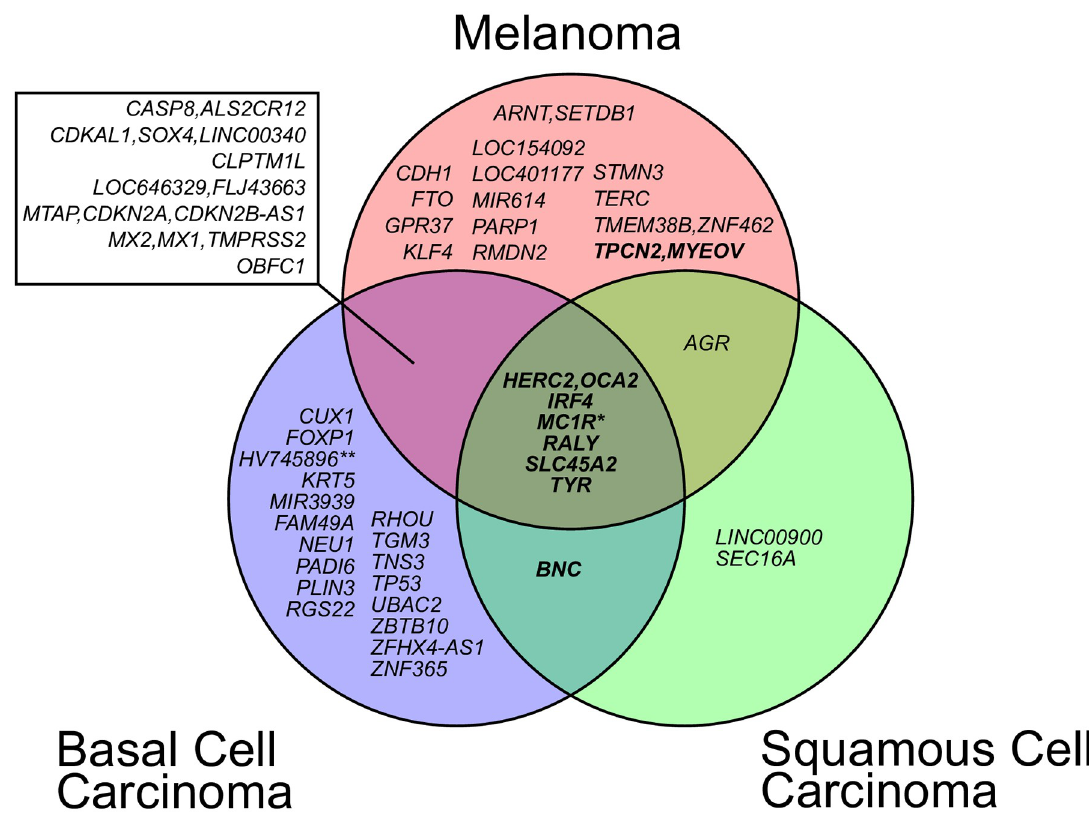
Fig 2. Overlap between the three skin cancer trait loci. Reported risk SNPs within 1 Mb were merged into the same locus. Loci that were also reported to be associated with skin tanning ability are highlighted in bold. Loci were named according to the closest RefSeq genes (except M1CR a 385 kb locus with 16 RefSeq genes and HV745896 named after a nearby, uncurated mRNA